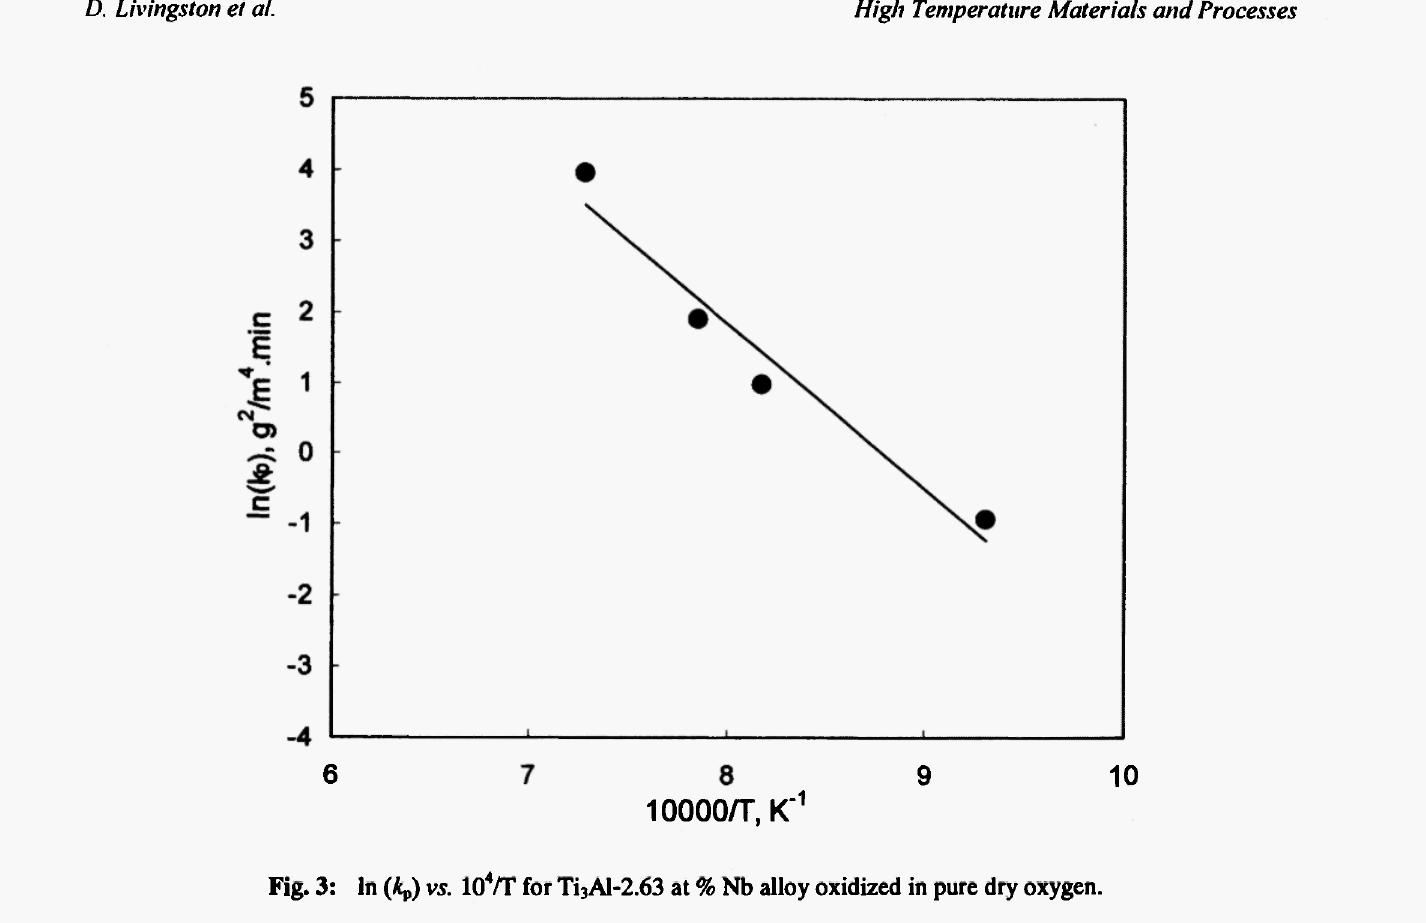
Al-2.63 at % Nb alloy oxidized in pure dry 3